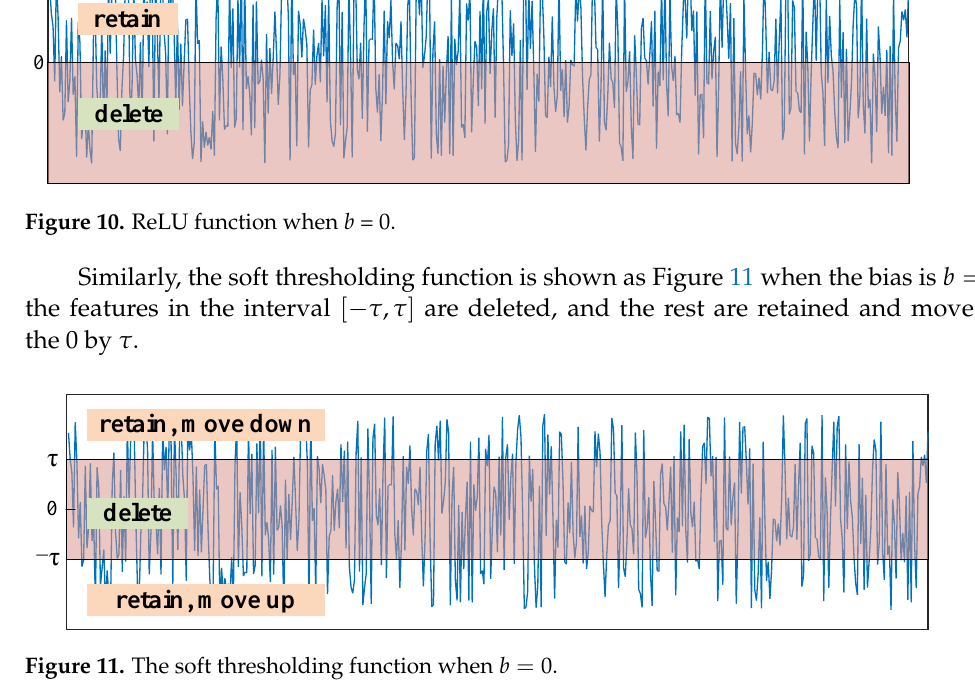
Figure 12. ReLU function when 𝑏 > 0 . The soft thresholding function becomes 𝑦 = 𝑠𝑖𝑔𝑛(𝑥 + 𝑏) ⋅ 𝑚𝑎𝑥( 𝑎𝑏𝑠(𝑥 + 𝑏) − 𝜏, 0) . The feature values are first shifted up by 𝑏 , and then feature values in the threshold in- terval are set to 0, as shown Figure 13: Figure 13. The soft thresholding function when b > 0.